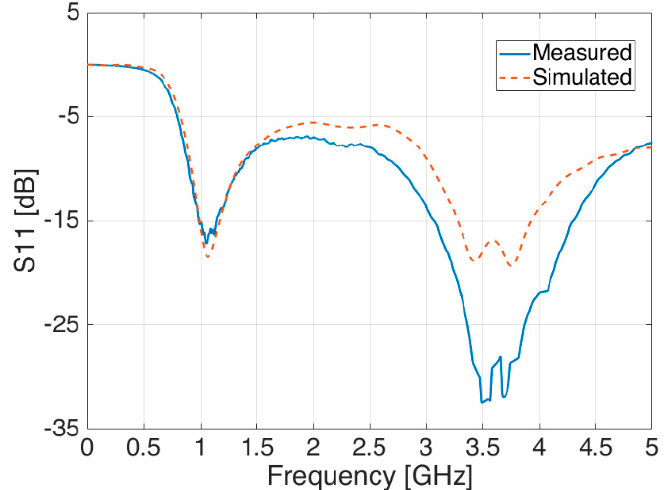
Figure 16. Layout of the anechoic chamber used for the antenna measurement, including intercon- nection details.